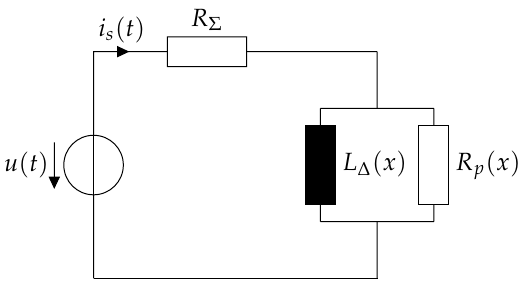
Figure 7. Electrical equivalent circuit for electromagnetic actuators under PWM operation.